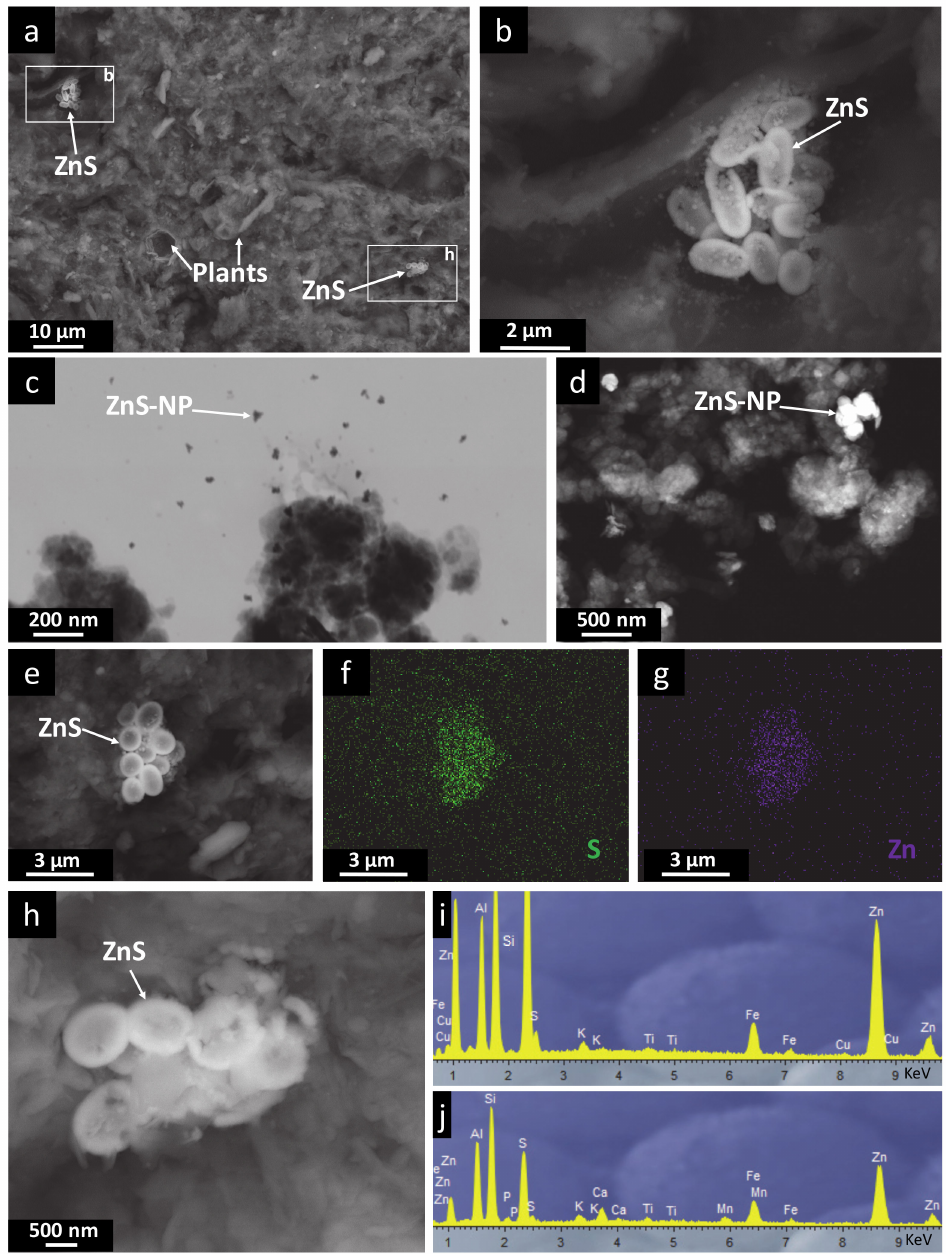
Figure 4. FE SEM and HRTEM images of the ZnS-bearing sediments from La Playa dam. ( a ) FESEM image of ZnS aggregates associated to plant fragments. Squares indicate the location of ( b , h ); ( b ) ZnS nanoparticles forming aggregates which oval and spherical shape and size closely resemble bacterial cell morphology; ( c , d ) HRTEM images showing ZnS nanoparticles scattered or attached to mineral surfaces; ( e ) FESEM image of ZnS cell-shaped aggregate; ( f ) elemental map (EDX) of S (image f); ( g ) elemental map (EDX) of Zn (image f); ( h ) FESEM image of flattened cell-shaped aggregates due to cell collapse by cell lysis or EM sample preparation; ( i , j ) EDX spectra of ZnS cell-shaped